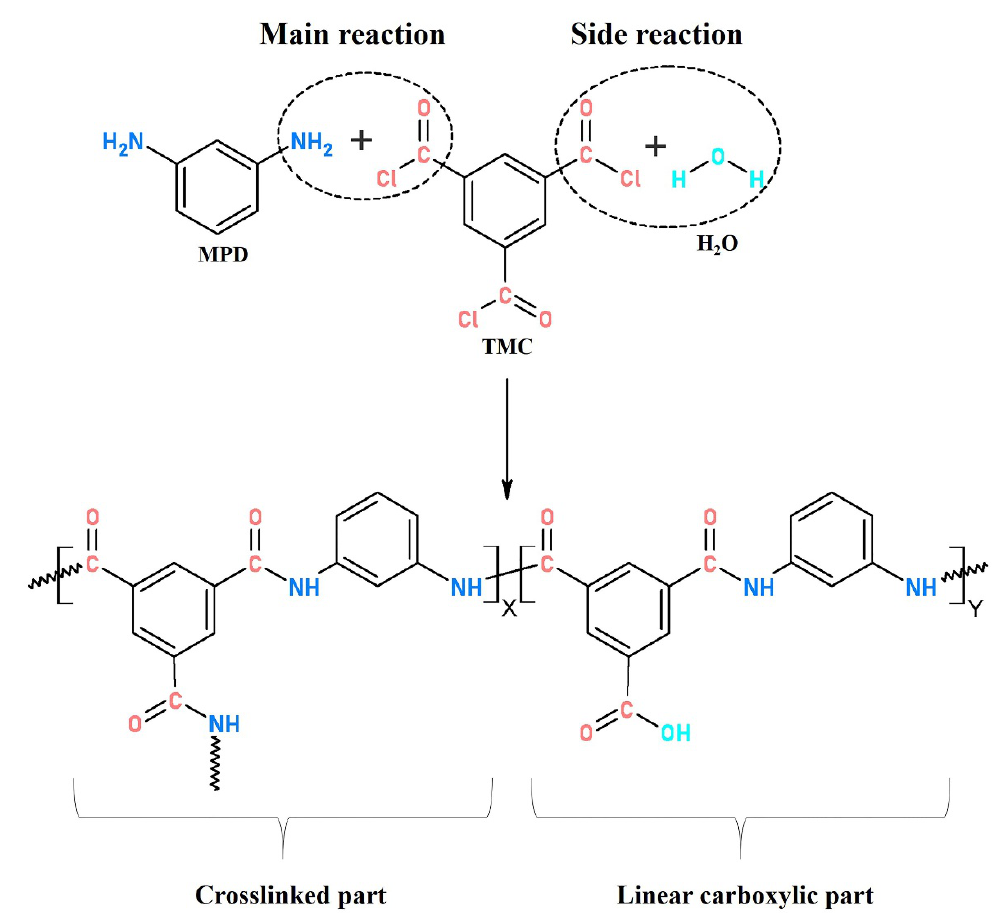
Figure 5. Typical structure of interfacially polymerized polyamide.